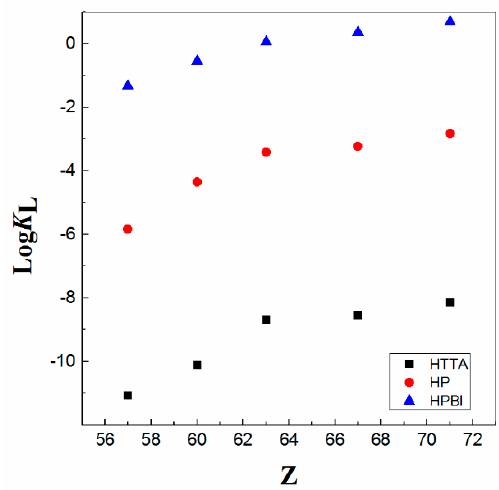
Figure 4. Log K L of various chelating ligands (diluent CHCl 3 ) vs. atomic number Z of La, Nd, Eu, Ho, and Lu. Adaptation from data Refs. [8,12].